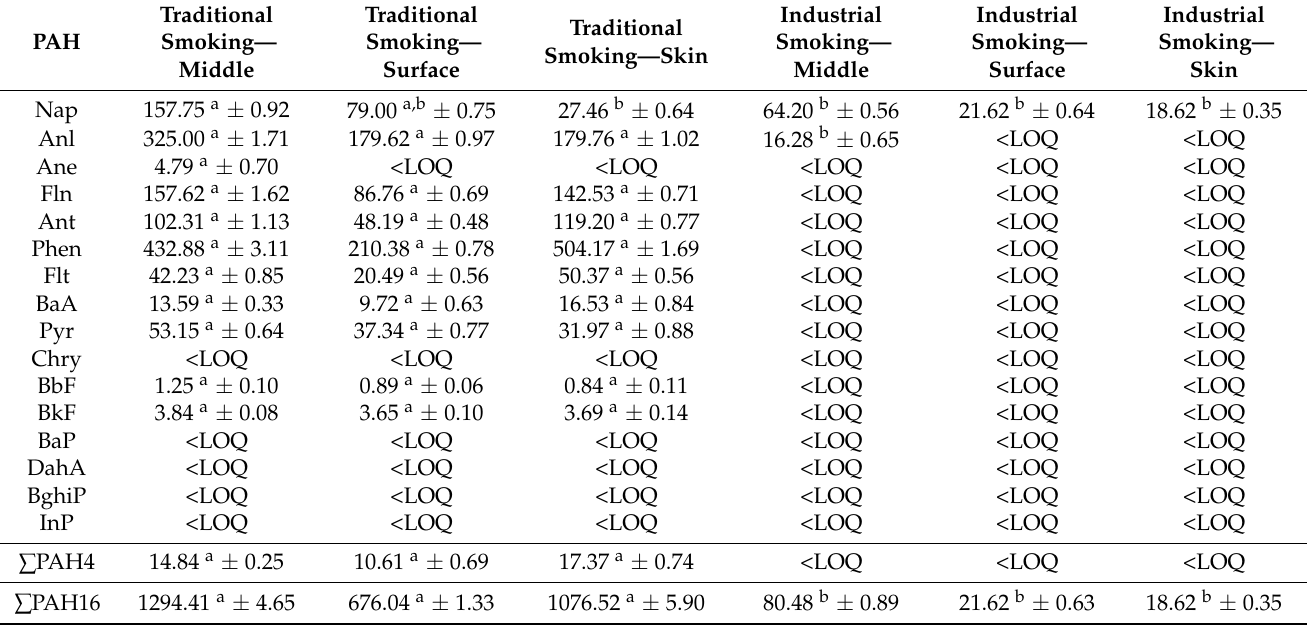
Table 2. PAH contents ( µ g kg − 1 ) in Slavonska slanina